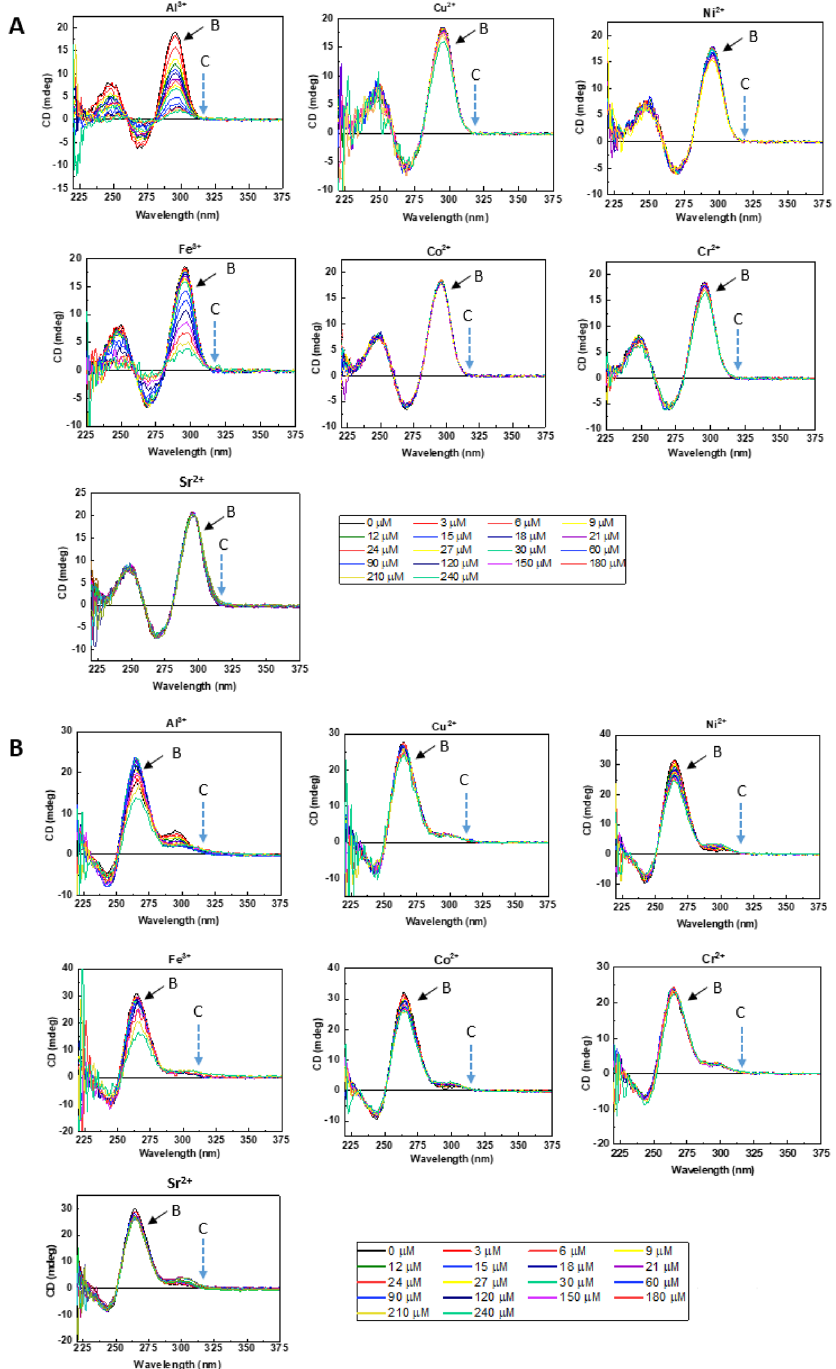
Figure 5. Cross-reactivity of G-QDs to metal ions. ( A ) Cross-reactivity of metal ions to TBA. ( B ) Cross- reactivity of metal ions to PS2.M. Black arrows indicate the K + -induced peak. Blue-dot arrows indicate the wavelength of Pb 2+ -induced G-QDs (314 nm for both